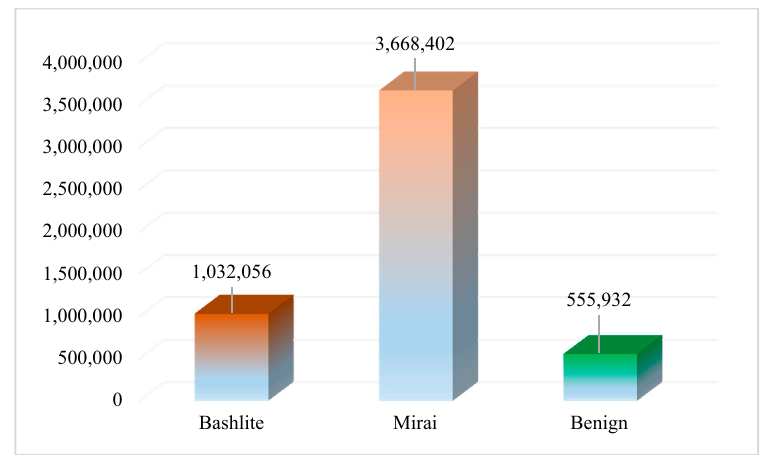
Figure 3. Number of instances in the dataset for Mirai, Bashlite, and benign classes.